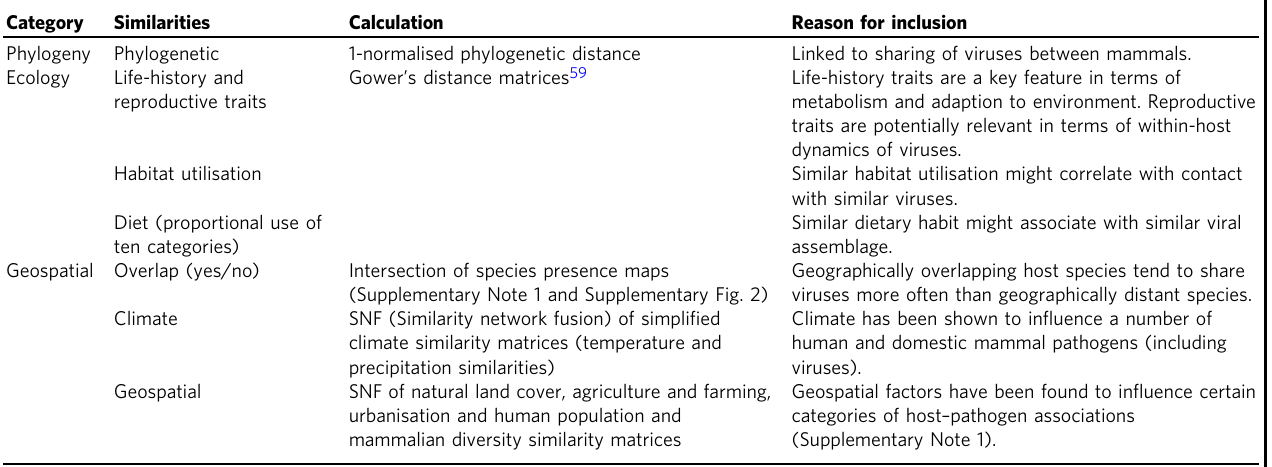
ffiffiffiffiffiffiffiffiffiffiffiffiffiffiffiffiffiffiffiffiffiffiffiffi P q V f l ½ i (cid:2) 2 d m i ¼ 1